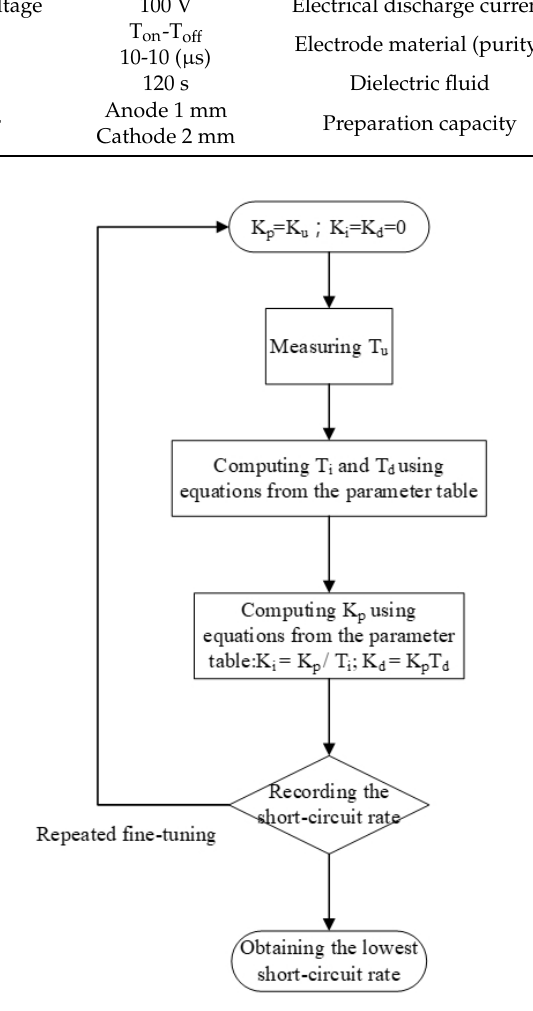
Figure 9. Proportional–integral–derivative (PID) parameter fine-tuning flow chart.